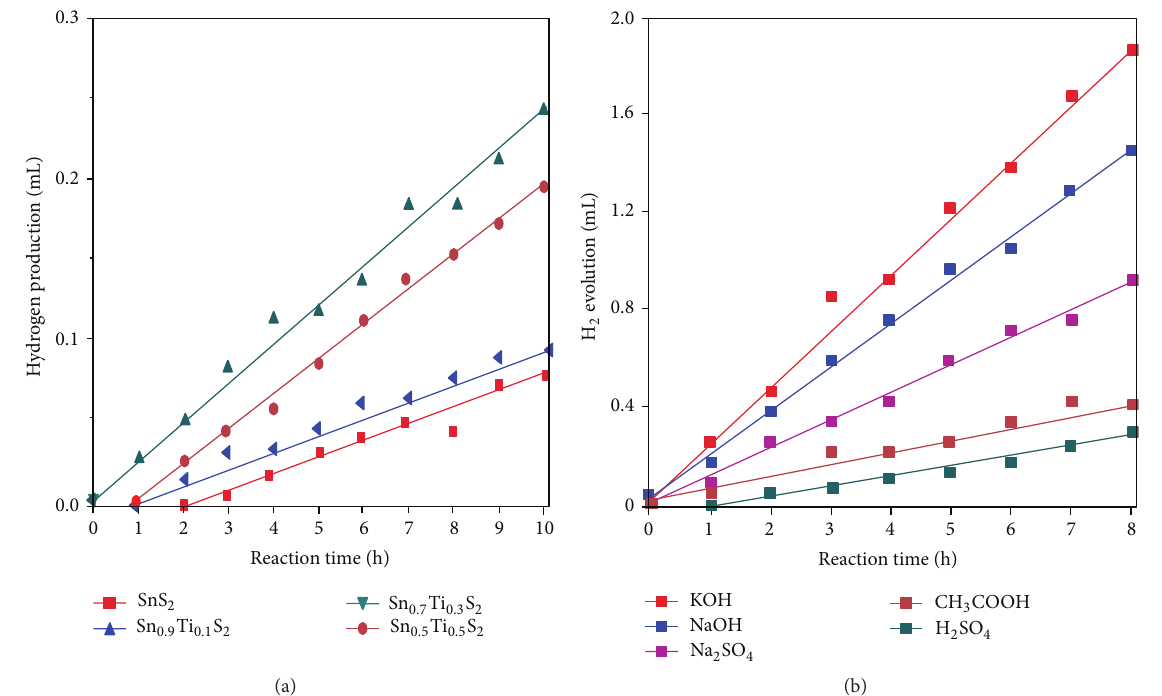
Figure 6: Evolution of H 2 gases from MeOH/H 2 O photosplitting over the as-synthesized SnS 2 , Sn 0.9 Ti 0.1 S 2 , Sn 0.7 Ti 0.3 S 2 , and Sn 0.5 Ti 0.5 S 2 photocatalysts. (a) On the photocatalysts without electrolytes and (b) on Sn 0.7 Ti 0.3 S 2 with various